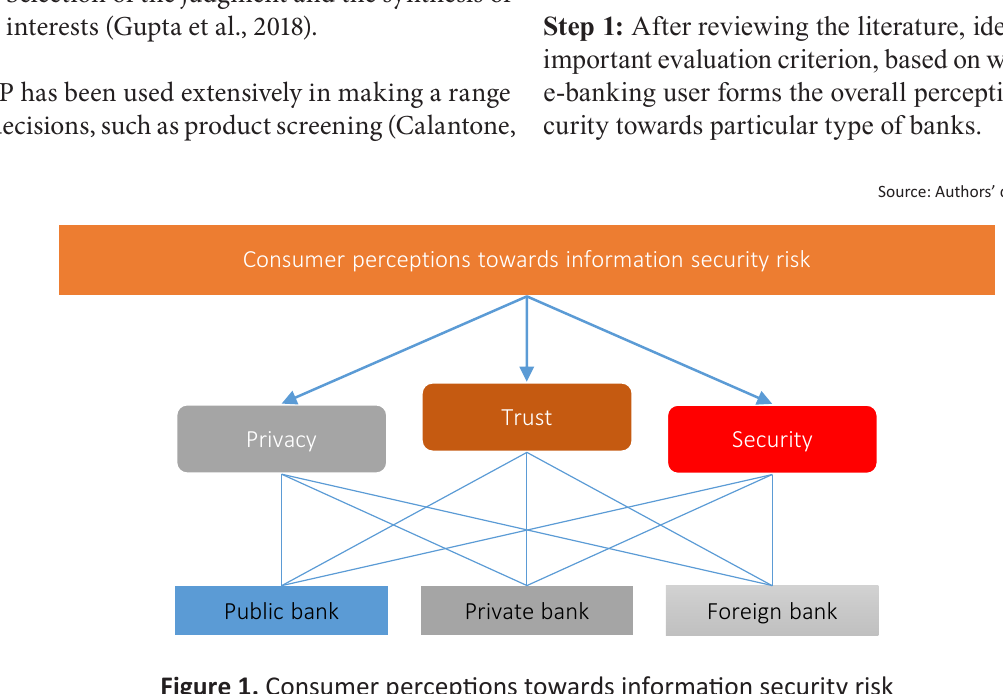
Figure 1. Consumer perceptions towards information security risk for public, private and foreign